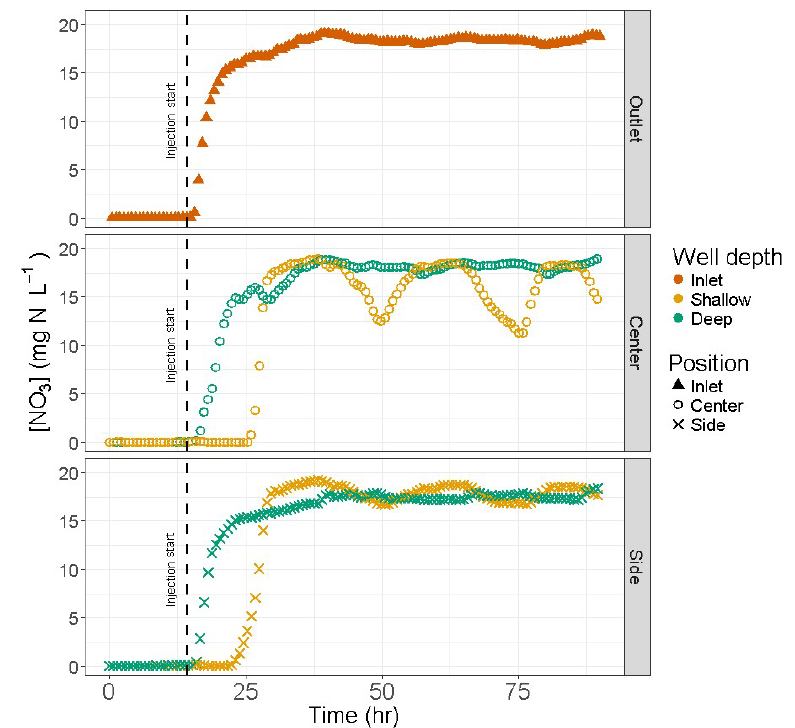
Figure 4. Nitrate concentration at outlet and wells near the outlet before and during the KNO 3 injection. Color indicates bioreactor outlet and depth of sampling wells, and shape indicates the position of the well transect (centerline or near the side